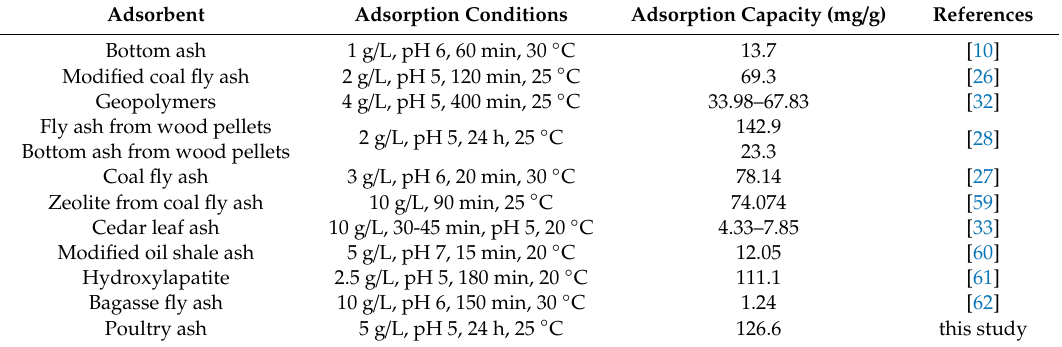
Table 3. Comparison of the Langmuir equilibrium capacities for selected mineral sorbents of Cd under specific adsorption